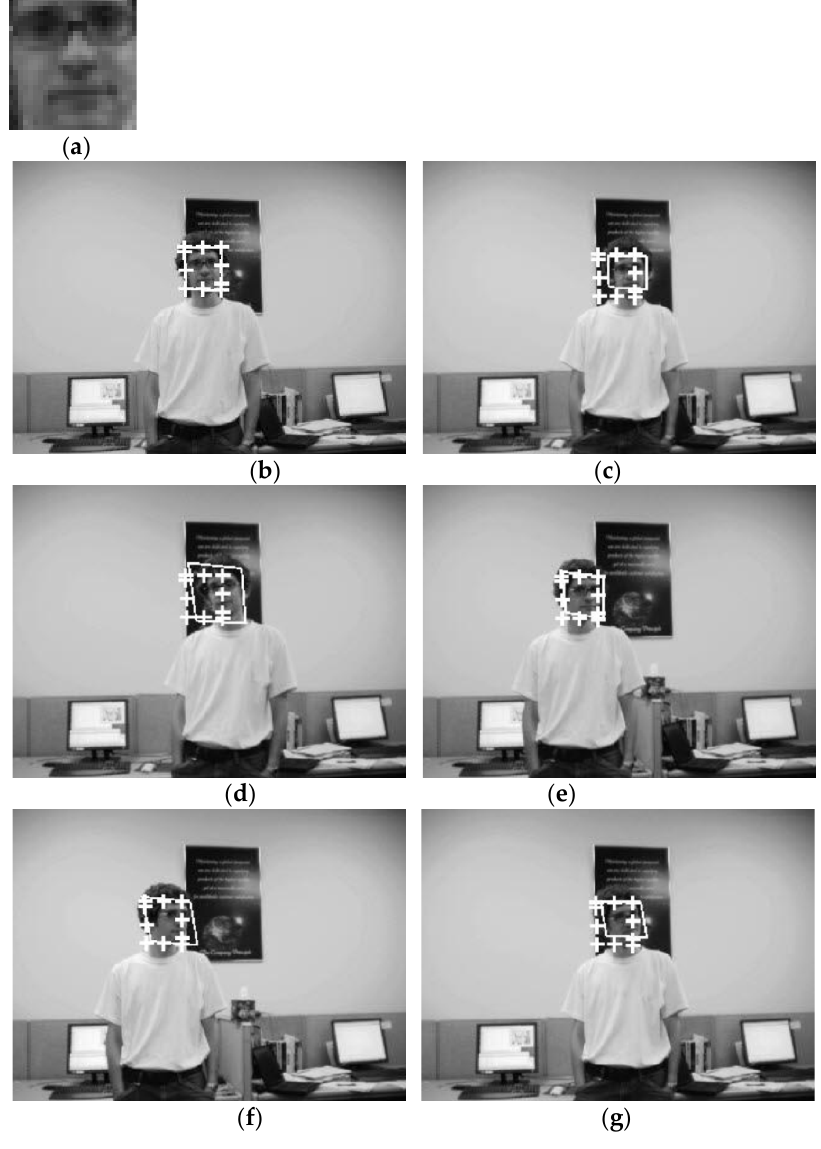
Figure 7. Selected results of face detection using David open data sets [22]. The first image ( a ) is the template. The face detection problem is to find the same person as the template in various images with different poses and sizes from the template, such as images ( b )–( g ).